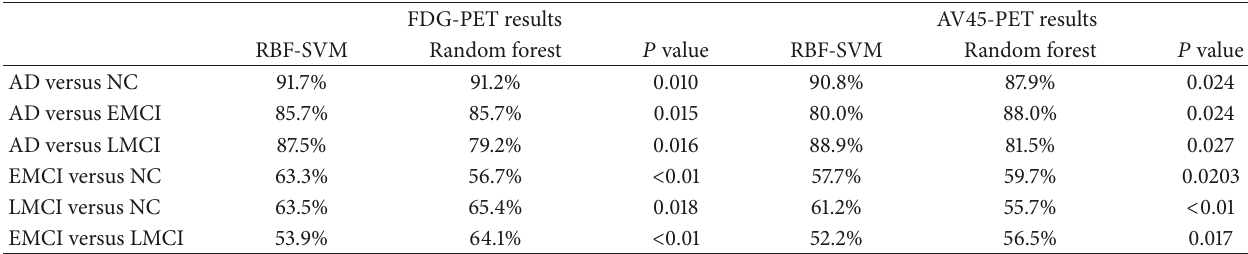
Table 5: Comparison in classification accuracy between FDG-PET and AV45-PET using combination of baseline and second-visit timepoints for all diagnostic